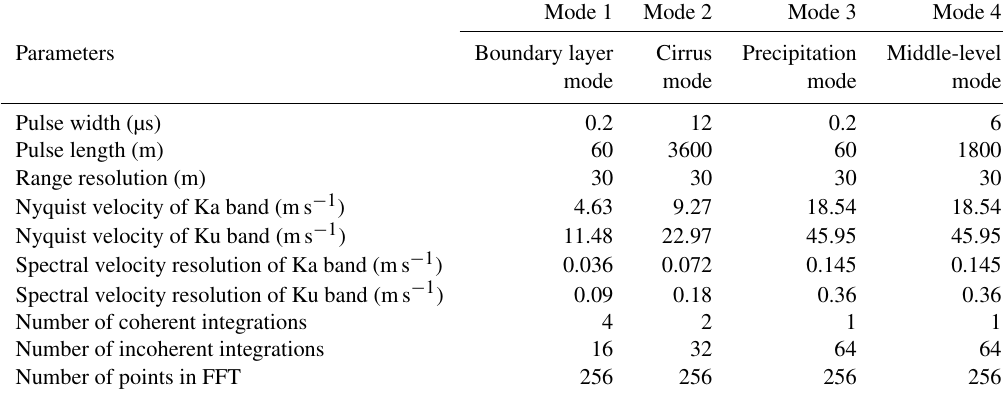
Table 1. Operating parameters for the Ka–Ku-band cloud radar system deployed at Longmen Observation Station in southeastern